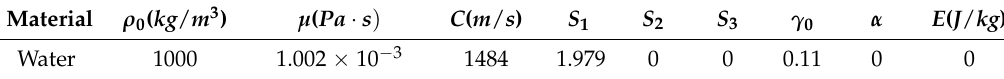
Table 4. Water properties and parameters.